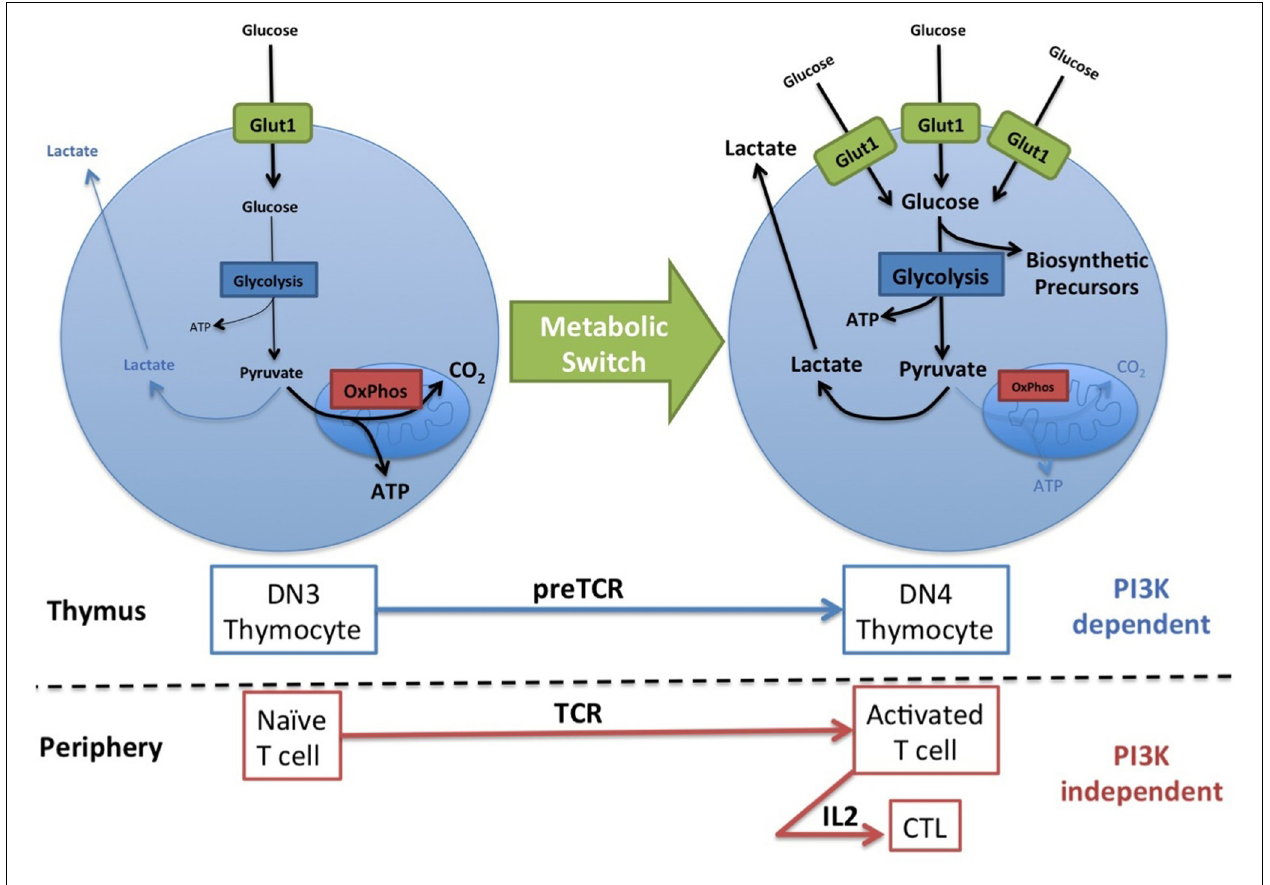
and increase glycolytic flux, primarily converting glucose to lactate. This metabolic switch increases the biosynthetic capacity of theT cells and is stimulated by antigen receptor signaling (PreTCR,TCR) and maintained by certain cytokines (IL2). PI3K signaling is required for this metabolic switch during thymopoiesis but not in peripheral activatedT